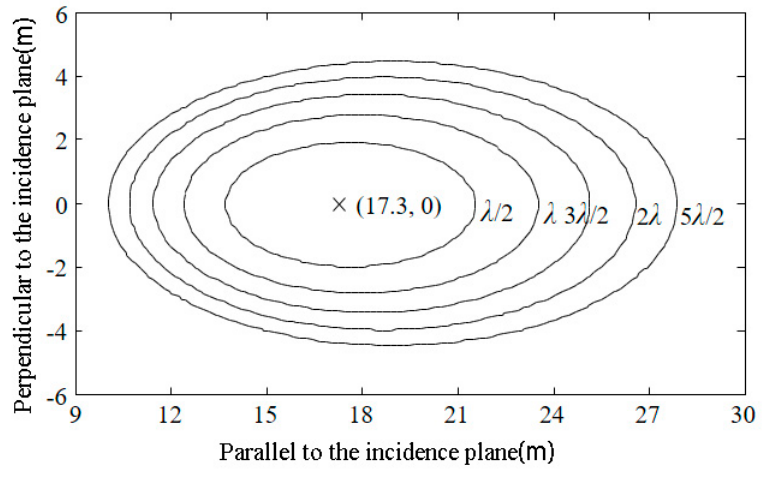
Figure 5. The shape of Equi-delay ellipses at a receiver height of 10 m and a grazing angle of